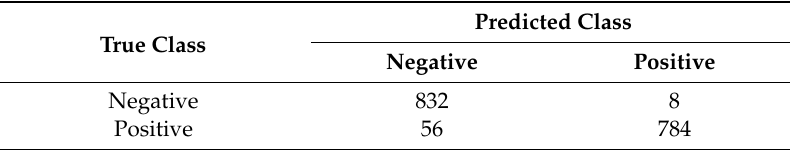
Table 10. Deep FC2 features and SVM